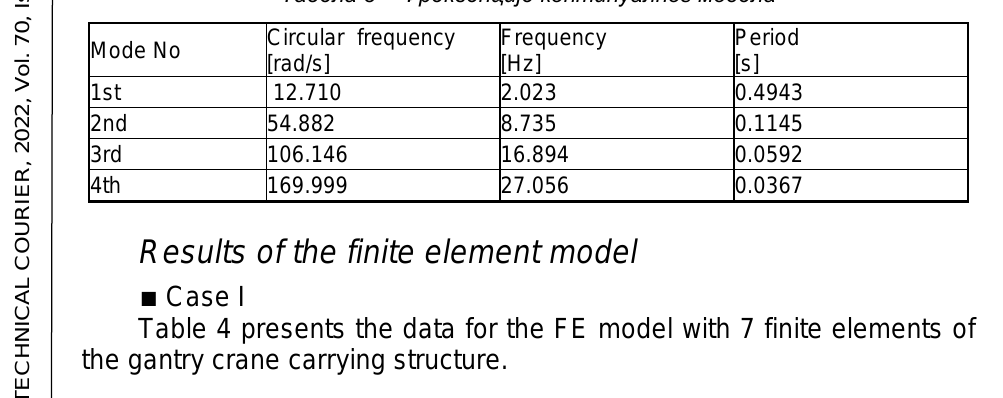
Table 3 – Frequencies of the continuous model